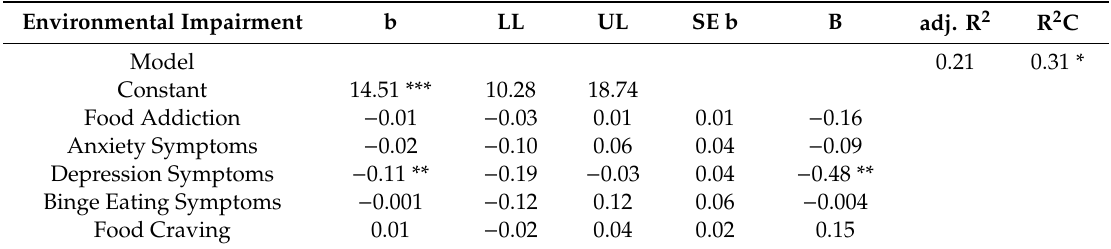
Table 6. Multiple regression results predicting environmental impairments measured using WHOQOL-bref. Environmental